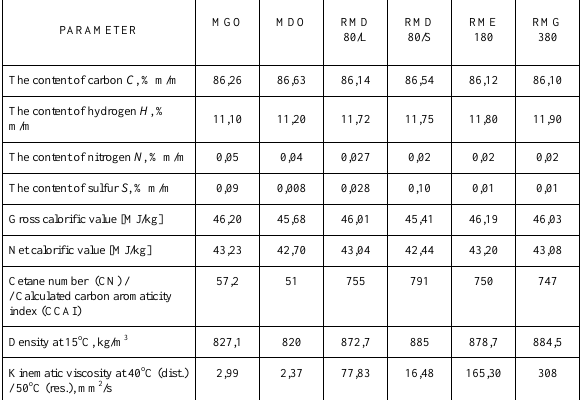
Table 1. Measurement results of elemental composition as well as energy and ignition properties of the considered low-sulfur marine fuels